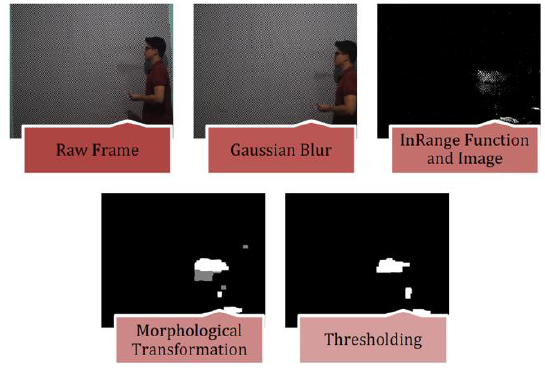
Figure 5. OpenCV Functions Applied to a Sample Frame This resulting binarized smoke detected video was also used in masking the raw video to have an output wherein the smoke was highlighted in the raw video. Drawing contour function was also used to return a video that could enclose the smoke pixels in a bounding rectangle that later used in computation for the extent. Different variations of the output video were saved to help in visualization and analyzation.